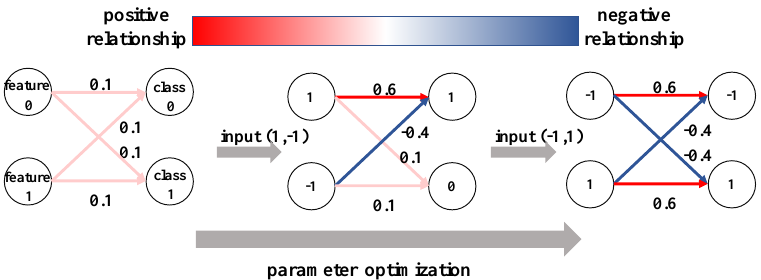
Figure 2. An example of the parameter-optimization process of deep-learning models. After the two-step update process, two output classes build up positive and negative relationships with different